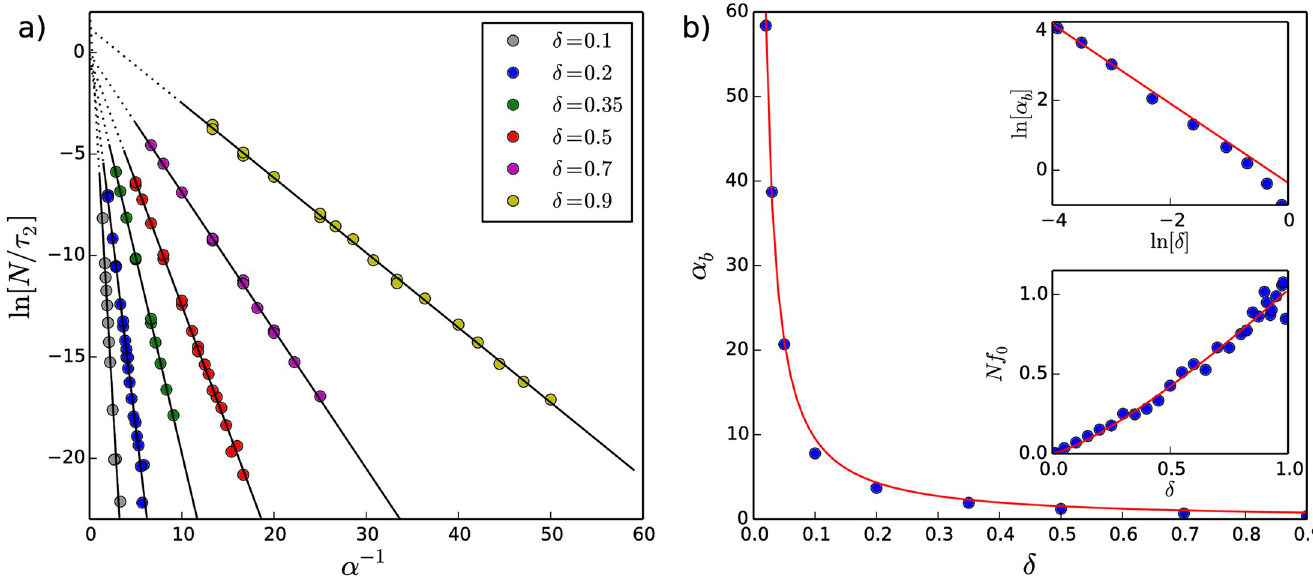
Fig 5. Arrhenius relationship between τ 2 and α and δ . a) Plots of ln[ N / τ 2 ] vs. α − 1 for various values of δ confirm the relationship proposed in the Arrhenius equation (Eq 8). The slope of each linear fit is − α ( δ ). A discussion regarding the evaluation of errors on the extracted values of τ 2 is included in Section G in S1 Appendix. b) b Dependence of α b and Nf 0 on the parameter δ : the red line in the main plot (linear scale) and upper inset (logarithmic scale) corresponds to α b = 0.53 δ − 1.21 ; the red line in the lower inset corresponds to Nf 0 = 1.03 δ 1.28